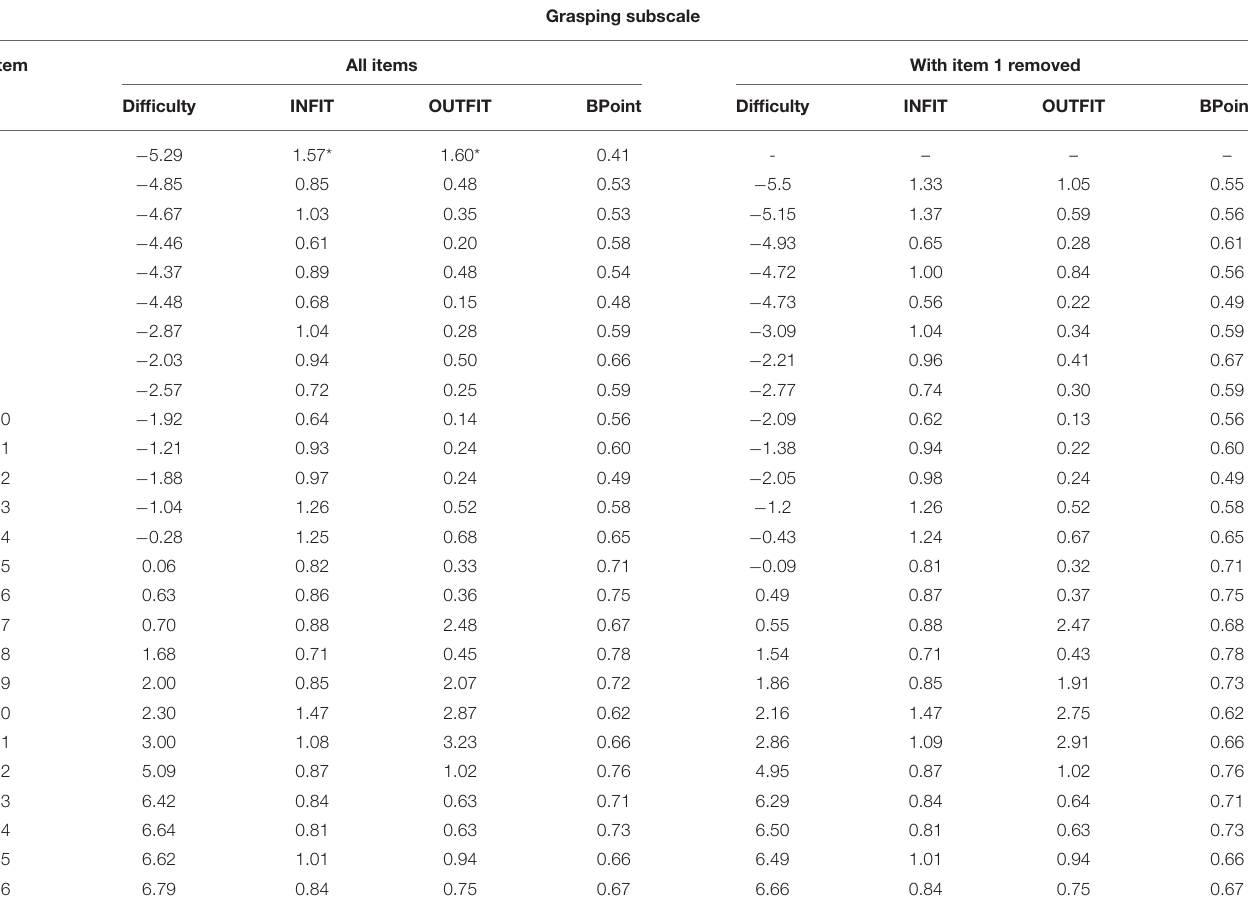
TABLE 6 | Grasping subscale: item difficulty, INFIT, OUTFIT, and point-biserial correlations before and after removing